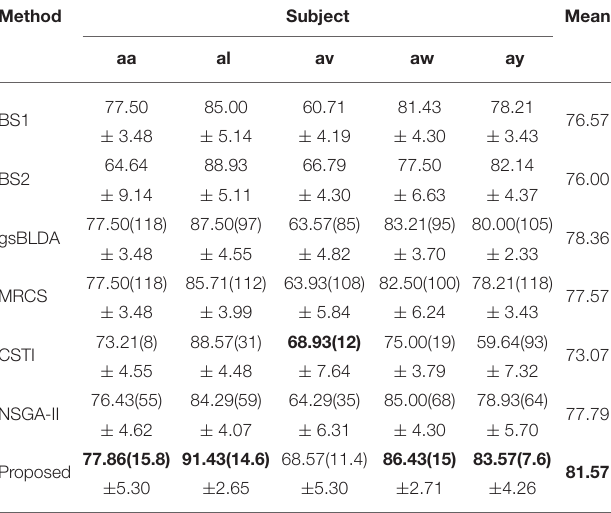
The best performance is highlighted in bold. Performance of BS1 and BS2 indicates classification accuracy with all channels and 3C channels, respectively.